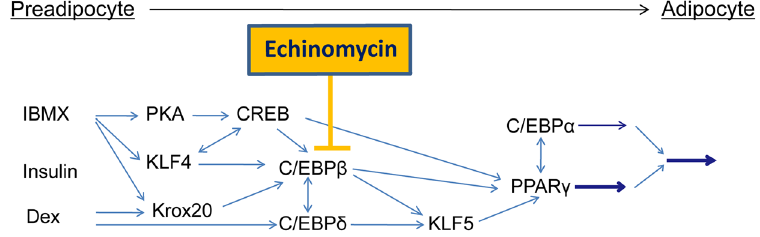
Figure 7. The scheme of echinomycin’s effect on adipogenesis proposed in this